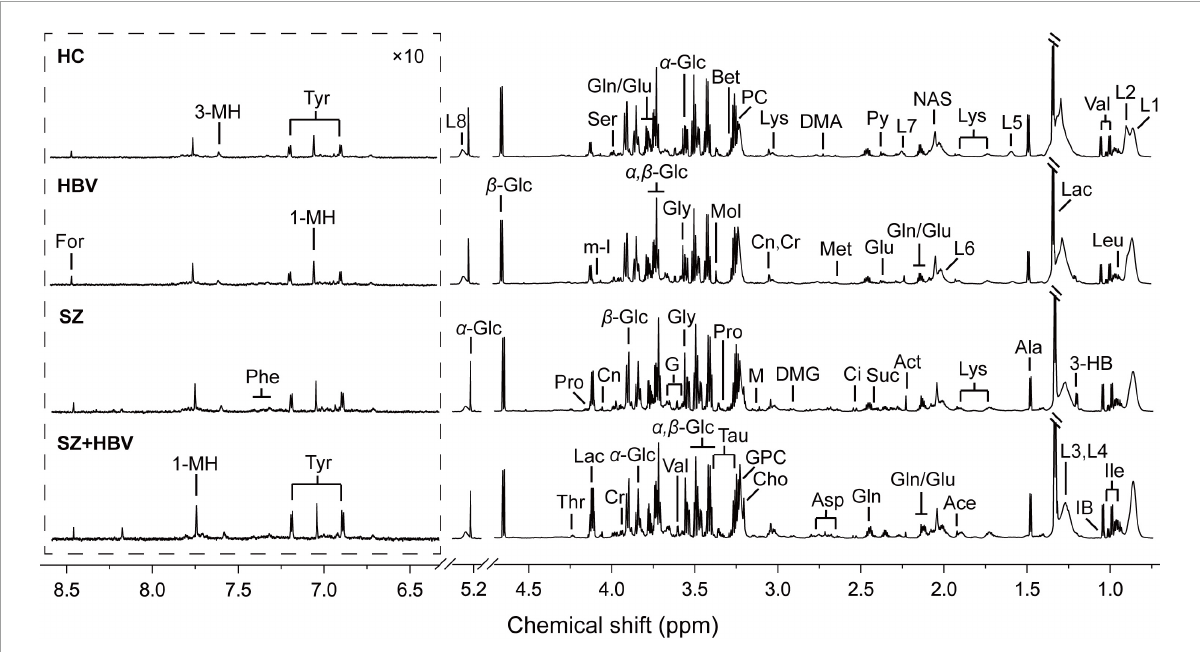
FIGURE1 Typical metabolic profiles revealed by 1 H NMR spectra at 850 MHz. Assignments were made as labeled for each group. Spectral regions from 6.3 to 8.7 ppm were displayed with a different scale for visual convenience. 1-MH, 1-methylhistidine; 3-HB, 3-hydroxybutyrate; 3-MH, 3-methylhistidine; Ace, acetate; Act, acetone; Ala, alanine; Asp, aspartate; Bet, betaine; Ch, choline; Ci, citrate; Cr, creatine; Cn, creatinine; DMA, dimethylamine; DMG, N,N -dimethylglycine; For, formate; G, glycerol; Glu, glutamate; Gln, glutamine; GPC, glycerophosphocholine; Gly, glycine; IB, isobutyrate; Ile, isoleucine; L1, LDL, CH 3 -(CH 2 ) n -; L2, VLDL, CH 3 -(CH 2 ) n -; L3, LDL, CH 3 -(CH 2 ) n -; L4, VLDL, CH 3 -(CH 2 ) n -; L5, VLDL, –CH 2 -CH 2 -C = O; L6, lipid, –CH 2 -CH = CH-; L7, lipid, –CH 2 -C = O; L8, lipid, –CH = CH-; Lac, lactate; Leu, leucine; Lys, lysine; M, malonate; Met, methionine; m -I, myo -Inositol; Mol, methanol; NAS, N -Actyl-glycoprotein signals; Phe, phenylalanine; PC, phosphocholine; Pro, proline; Py, pyruvate; Ser, serine; Suc, succinate; Tau, taurine; Thr, threonine; Tyr, tyrosine; Val, valine; α -Glc, α -glucose; β -Glc, β -glucose.